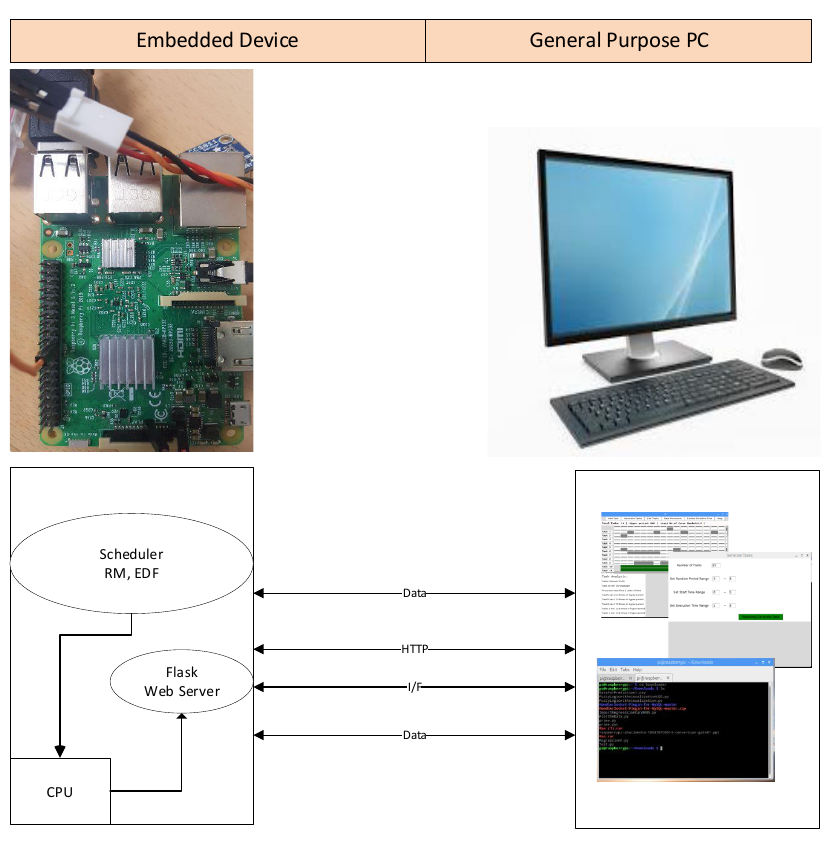
Figure 5. Implementation architecture.